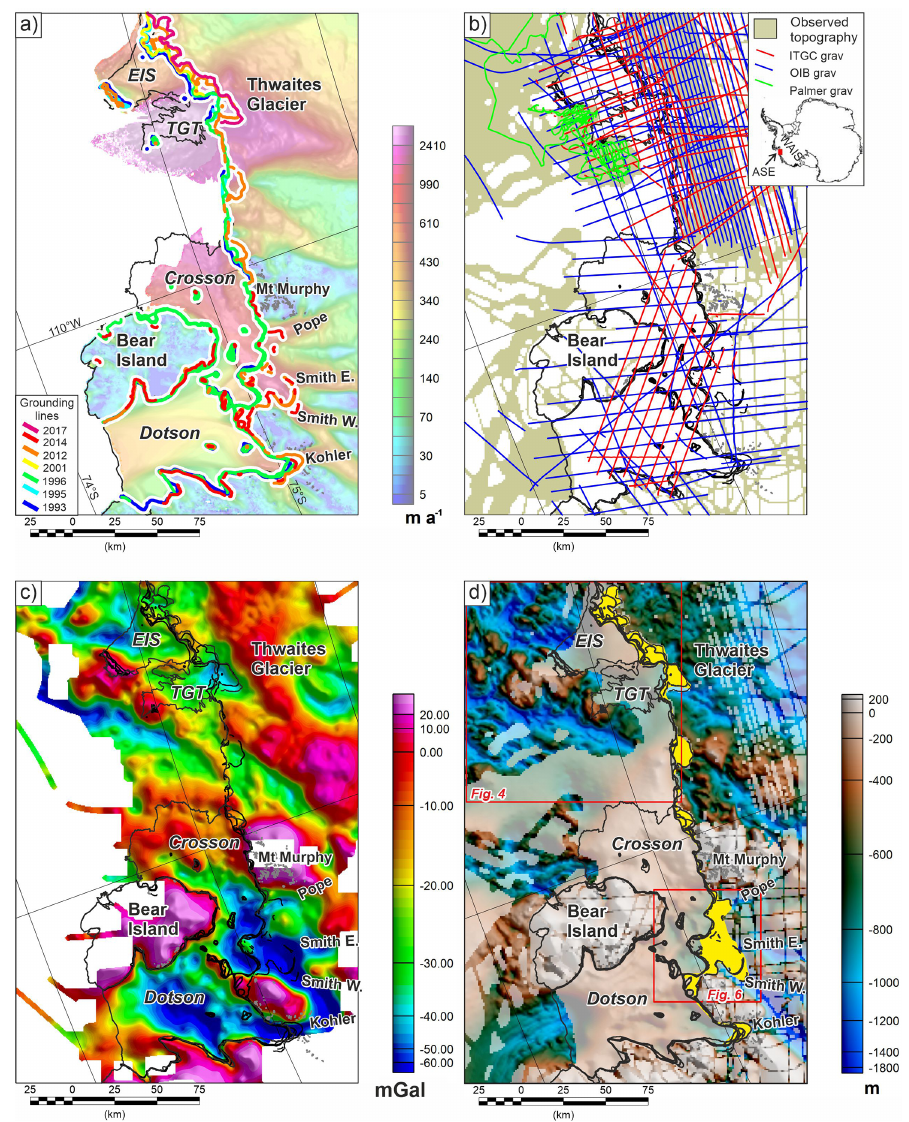
Figure 1. Regional setting and input data. (a) Ice velocity (Rignot et al., 2017) with grounding lines from interferometric synthetic aperture radar (InSAR) shown in colour (Rignot et al., 2014; Milillo et al., 2019); grey lines represent rock exposure. TGT and EIS denote the Thwaites Glacier tongue and Eastern Ice Shelf, respectively. (b) Line gravity data coverage, with regions of known topography and an inset showing Antarctic context. ASE is Amundsen Sea Embayment, and WAIS is the West Antarctic Ice Sheet. (c) Integrated free air gravity anomaly grid. (d) Topographic constraints, with direct observations shown in strong colors. Onshore these were taken from airborne radar including Operation Ice Bridge (OIB) (Paden et al., 2010, updated 2018) and the ITGC airborne survey. Offshore bathymetric data was taken from ship-borne swath coverage (Hogan et al., 2020). Pale colours show BEDMAP2 DEM (Fretwell et al., 2013). Yellow areas highlight post-1993 ice shelves. Red boxes show the locations of Figs. 4 and